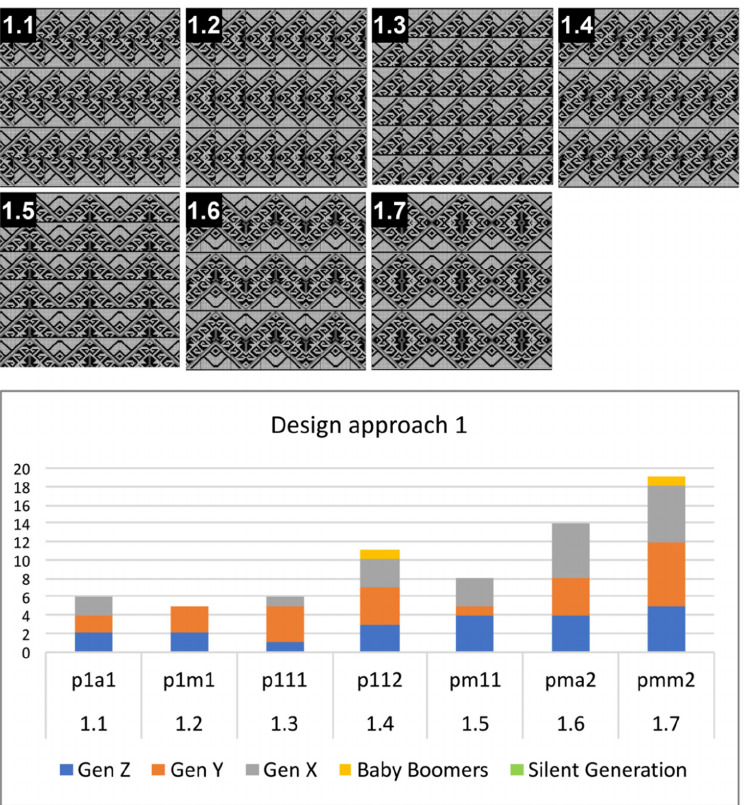
Figure 14. Design approach 1: seven frieze patterns and respondents’ preferences. (Illustration by Kunkhet and Chudasri).